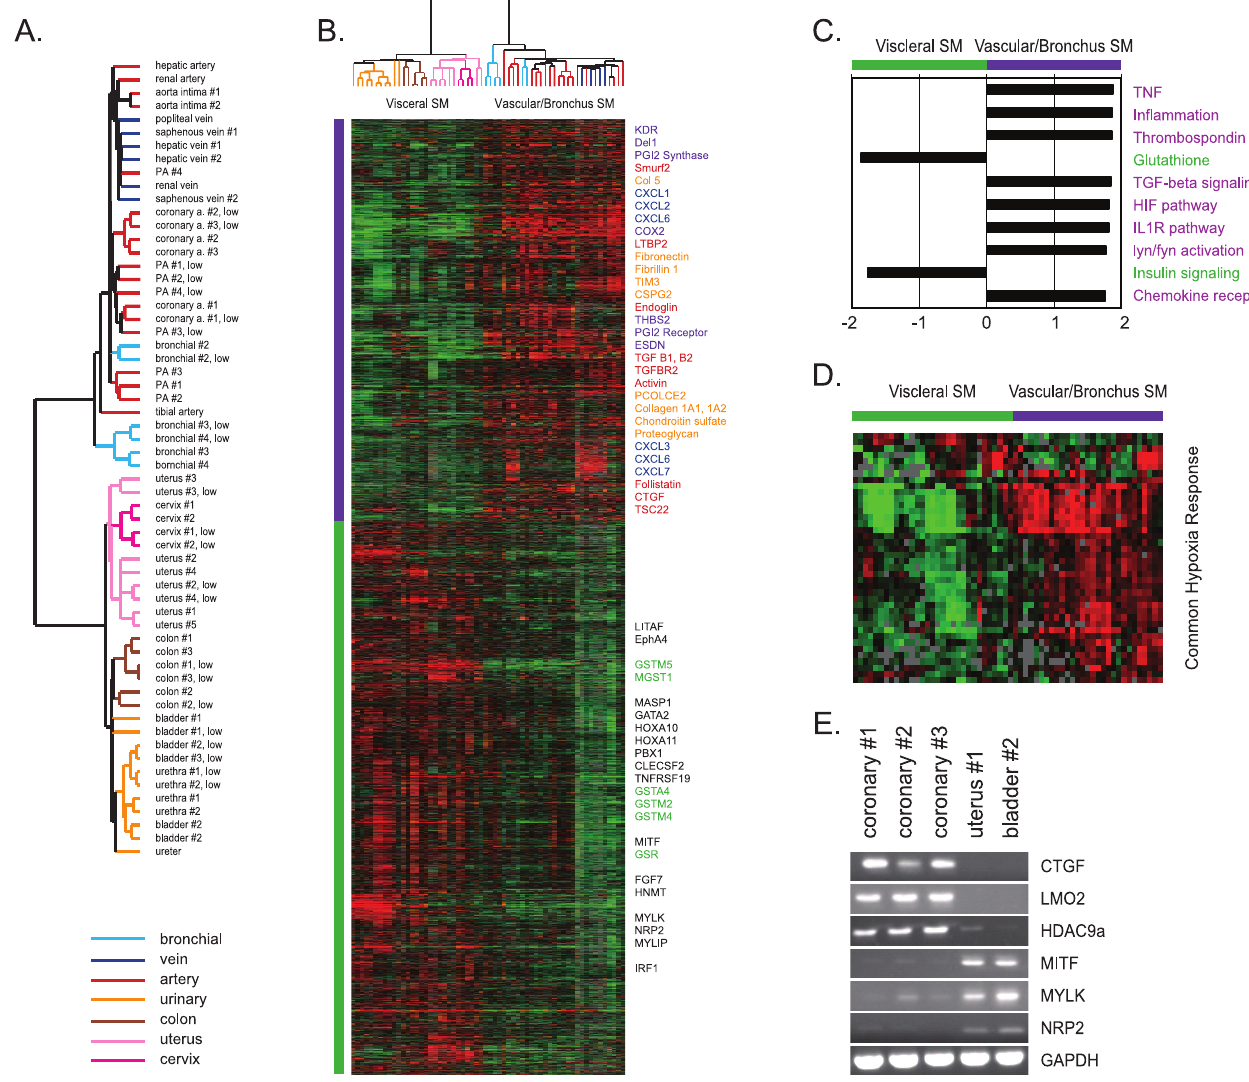
Figure 2. Vascular and Visceral SMC Gene Expression Programs (A) Identification of vascular and visceral SMC gene expression programs. Dendrogram representing the result of hierarchical clustering of SMCs, based on the similarities in their pattern of expression of the genes selected by a two class SAM test. (B) Features of vascular and visceral SMC gene expression programs. The expression of 2,338 vascular SMC-specific genes and 2,462 visceral SMC- specific genes selected by SAM analysis is shown here. Genes involved in TGF- b signaling (red), ECM components and biosynthesis (orange), inflammatory response (blue), and endothelial cell interaction (purple) are labeled by the indicated colors. Complete data can be found on the supplementary Web site and SMD. (C) Comparison of pathway activity in vascular and visceral SMCs by Gene Set Enrichment Analysis. The top ten molecular pathways ranked by normalized enrichment scores enriched specifically in vascular (purple, positive) or visceral (green, negative) SMC samples are shown. (D) The expression of a common hypoxia gene signature among all SMCs. The expression values of 71 genes constituting the common hypoxia response in the vascular versus visceral SMCs are shown. (E) Confirmation of specific expression of CTGF, LMO2, and HDAC9 in vascular SMCs; of specific expression of MITF, MYLK, and NRP2 in visceral SMCs; and of control gene GAPDH in all SMCs with